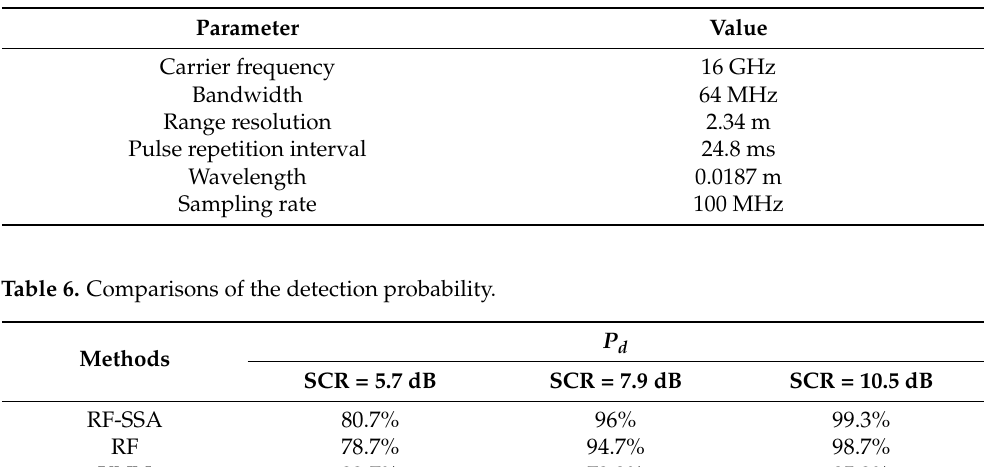
Table 6. Comparisons of the detection probability.